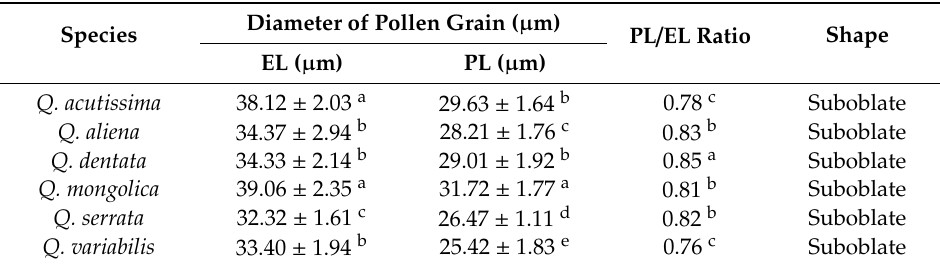
Figure 5. Structure of Quercus pollen walls under TEM. ( A ) Q. dentata , ( B ) Q. mongolica , ( C ) Q. aliena , ( D ) Q. variabilis , ( E ) Q. serrata , ( F ) Q. acutissima . Abbreviations: c, collumella; e, endexine; i, intine; p, pollenkitt; t, tectum. Scale bars represent 200 nm.